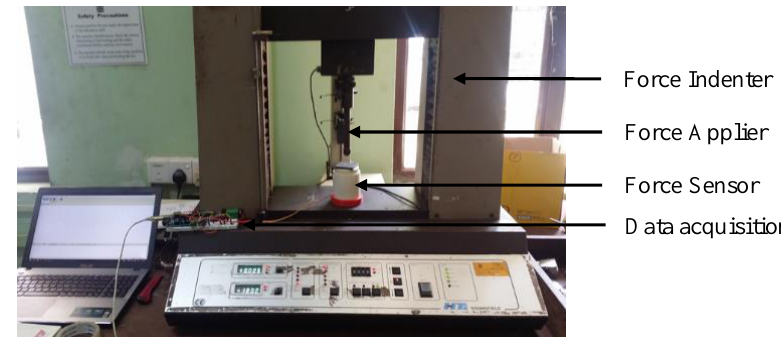
Figure 20. Force indenter is used for sensor characterisation.